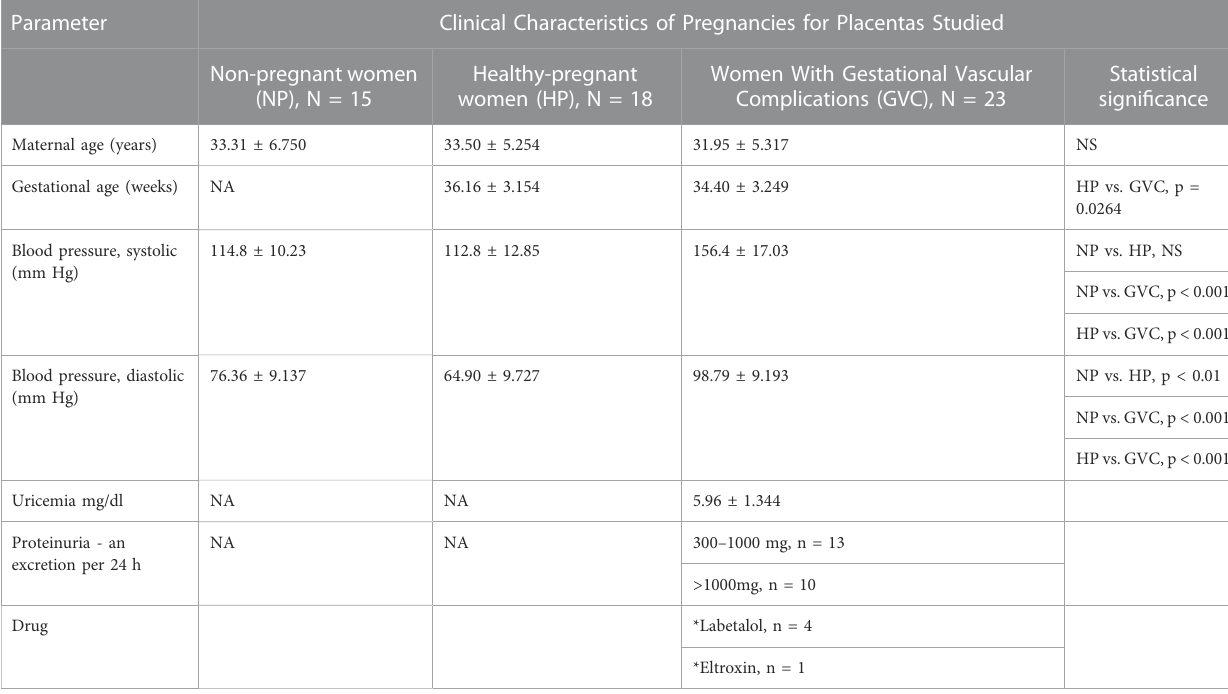
TABLE 1 Clinical Characteristics of non-pregnant and pregnant woman.